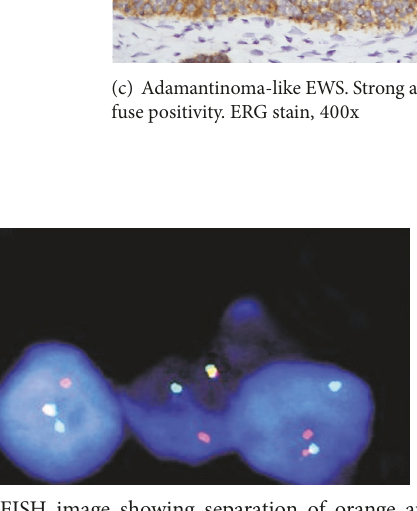
Figure 5: FISH image showing separation of orange and green fluorescence indicating presence of EWSR1 translocation.